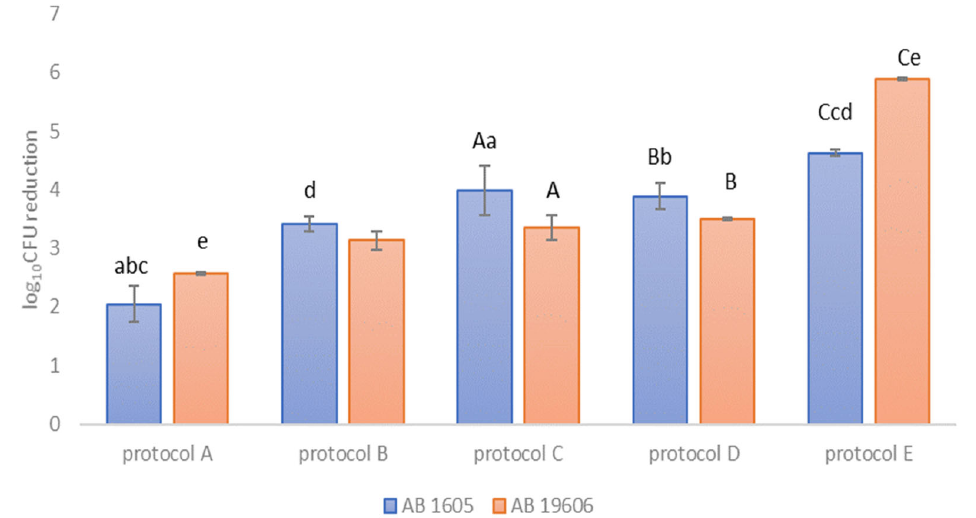
Figure 1. Viable bacteria count expressed as log 10 CFU reduction of Acinetobacter baumannii ATCC